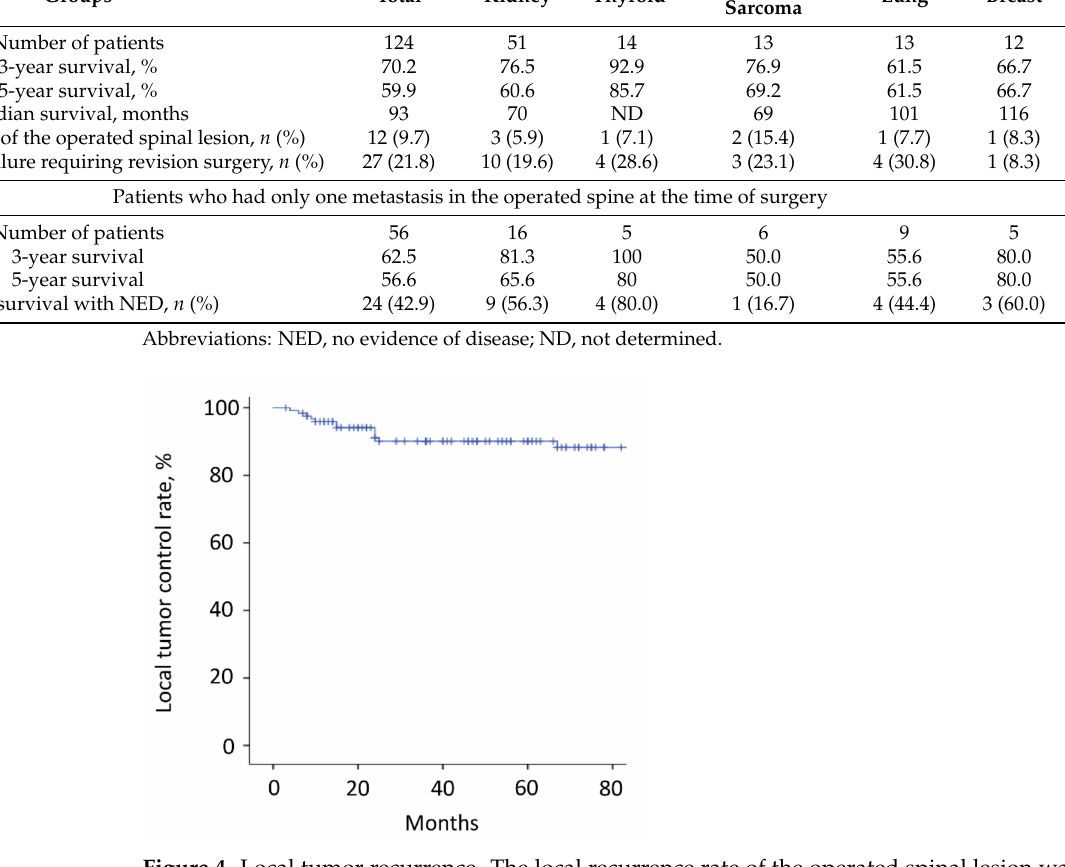
Figure 4. Local tumor recurrence. The local recurrence rate of the operated spinal lesion was 10% (12 patients). The 3-year and 5-year local tumor control rates were both 90%. All but one patient (11 patients) had a local tumor recurrence in the operated spine within 3 years after surgery. The tick marks indicate the last date of follow-up.